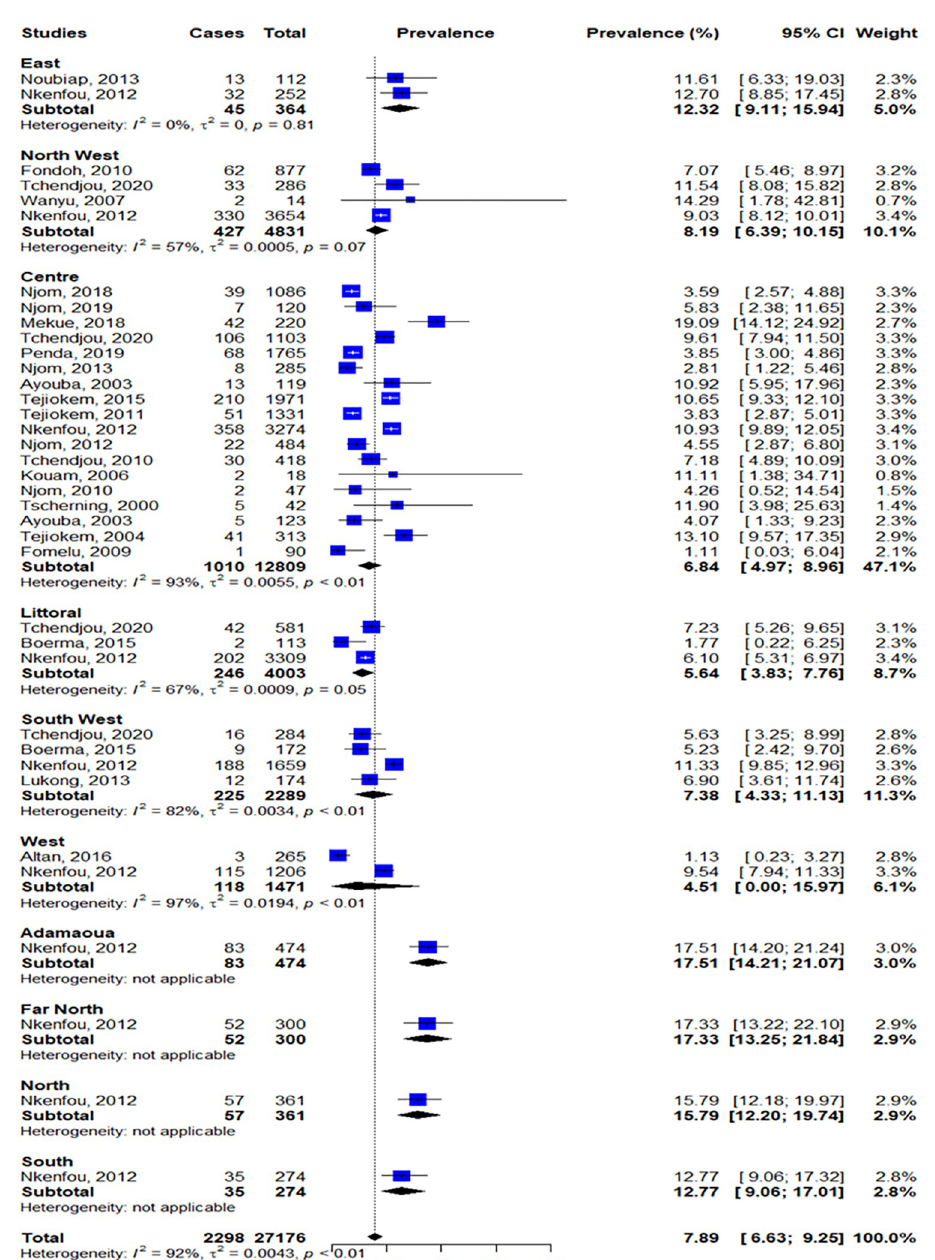
Fig 4. Forest plot of MTCT in the ten regions of Cameroon. The number of participants obtained in this forest plot depend on the studies that reported the region of sampling.